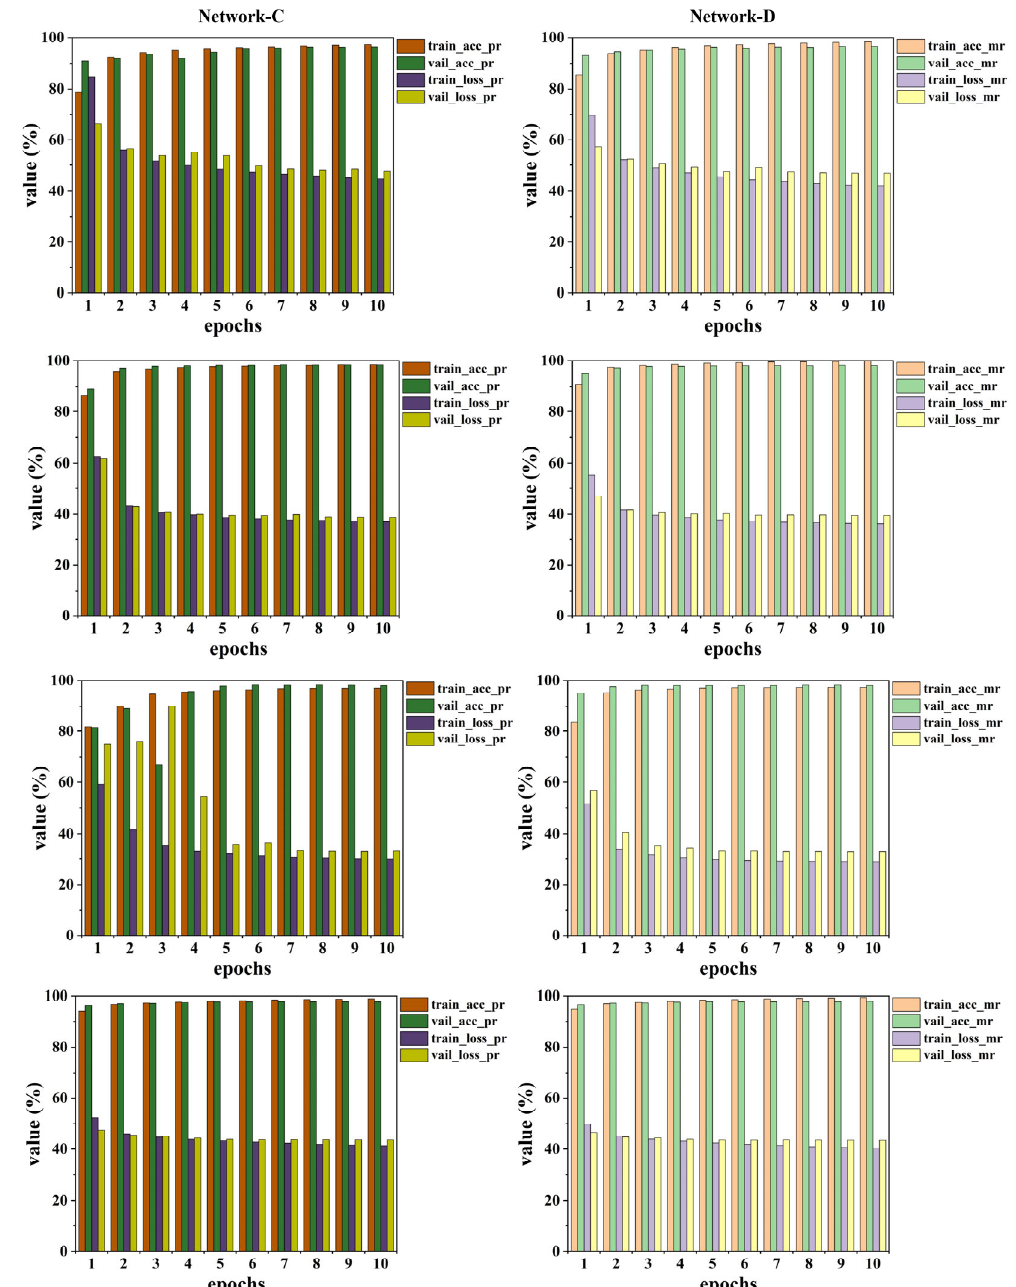
Figure 9. Comparison of Network ‐ C and Network ‐ D training processing.